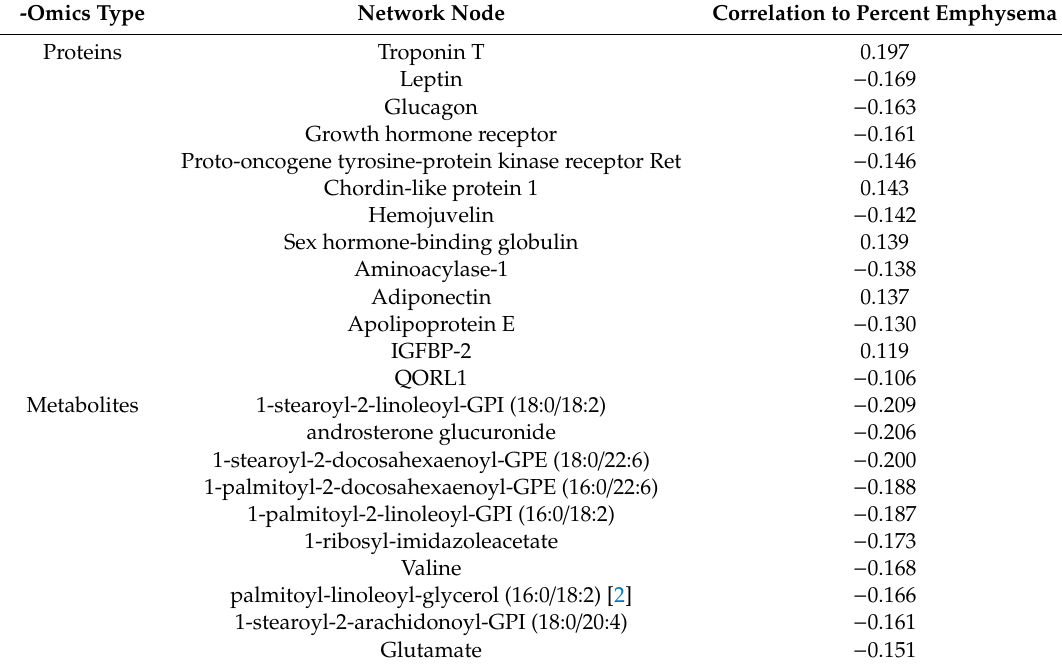
Table 3. Individual network node correlations to percent